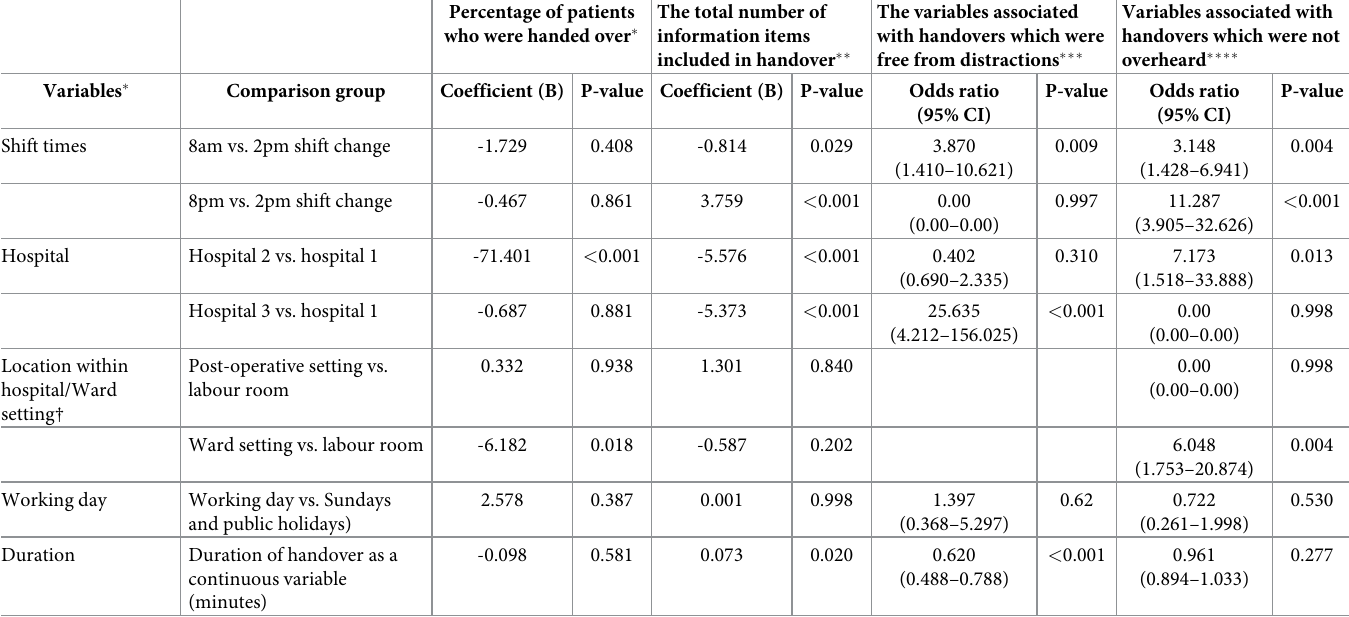
Table 3. Multivariate analysis of variables associated with the percentage of patients who were handed over, variables associated with the total number of informa- tion items included in handover, variables associated with handovers which were free from distractions, variables associated with handovers which were not